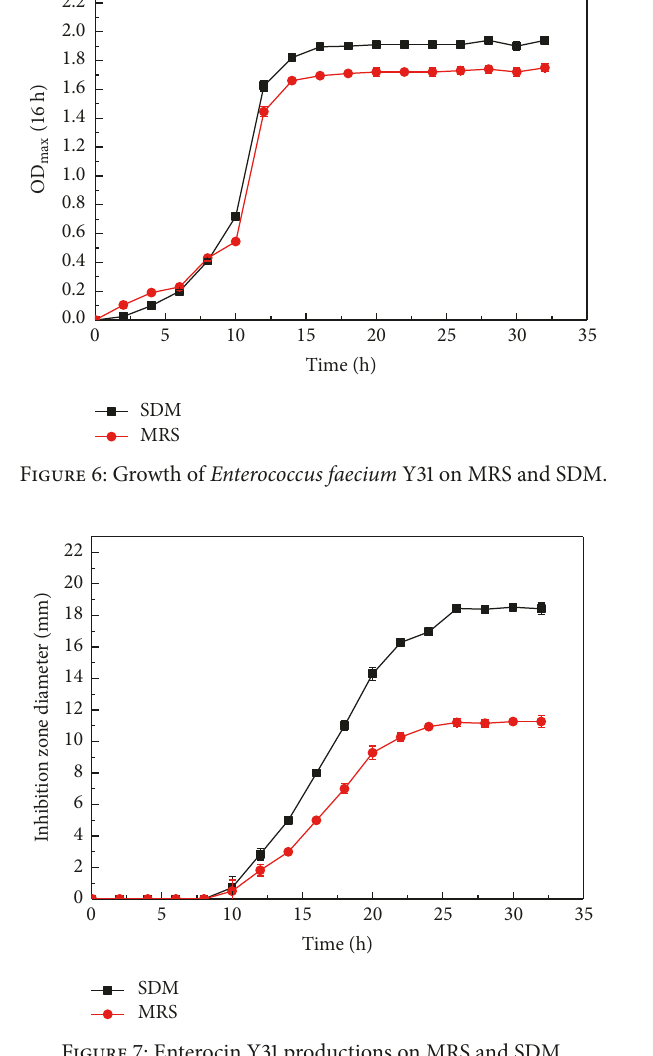
Figure 7: Enterocin Y31 productions on MRS and SDM.